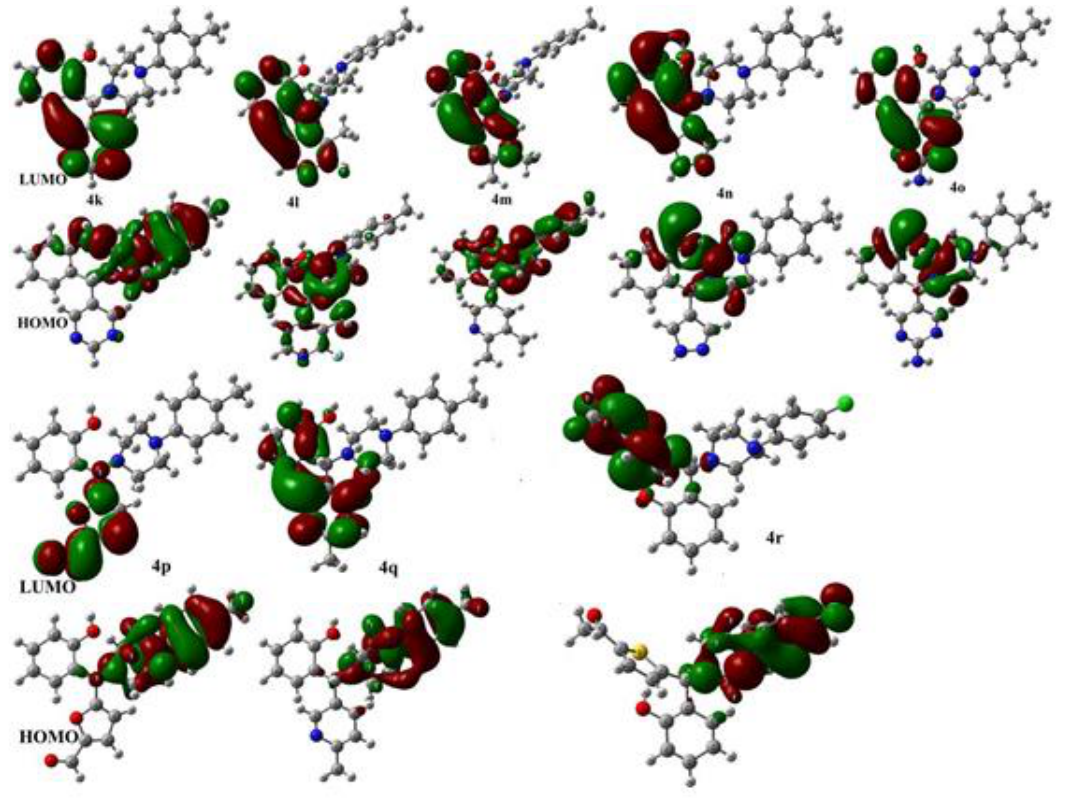
Figure 3. Computed molecular orbital plots for synthesized molecules 4a-4j with the counter value of 0.02 Å −3 .